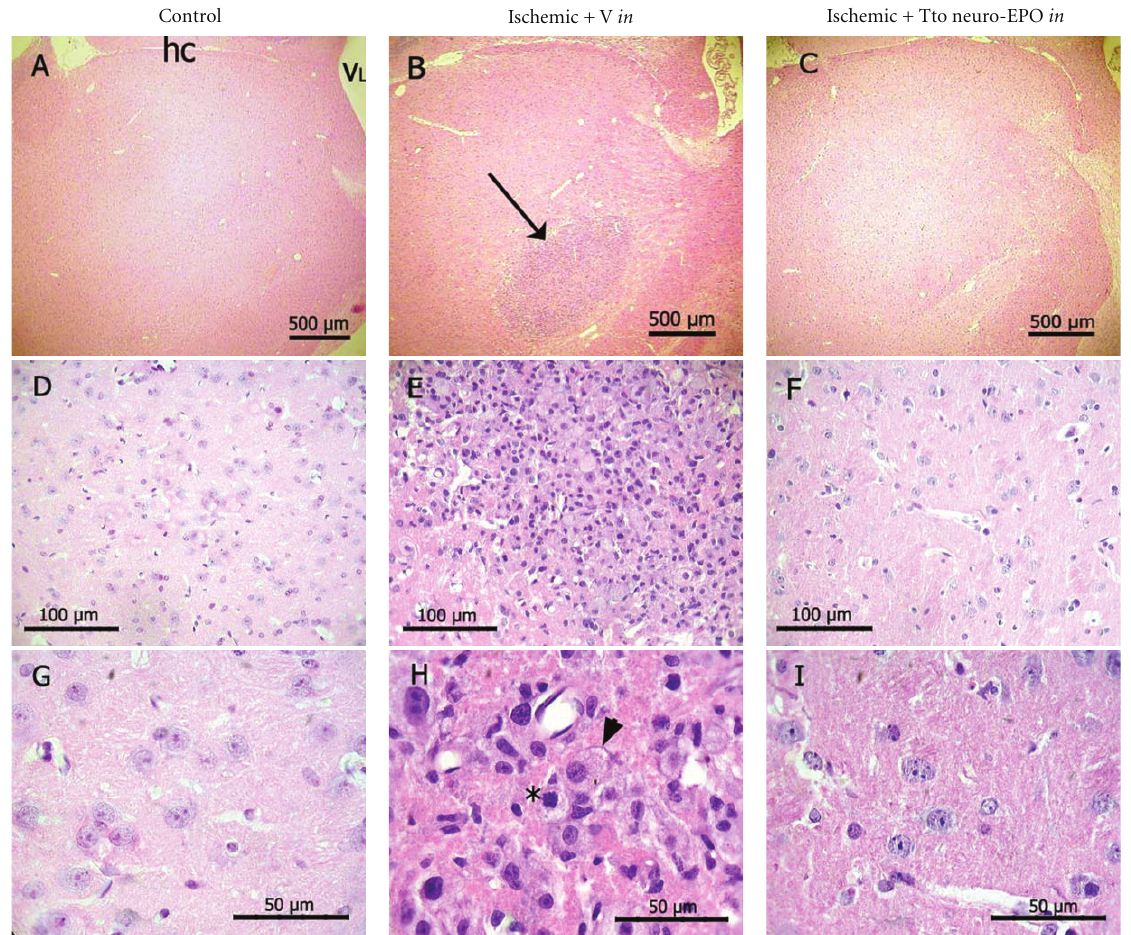
Figure 6: Model of focal ischemia thalamus. Unilateral ischemia produces large clusters of macrophages in the nuclei of the thalamus (B, E, H). The thalamus damage decreases with Neuro-EPO in (C, F, I). H-E. A, B, C: Panoramic view. Arrow: focus of macrophages. VL: lateral ventricle; hc: hippocampus. D, E, F: × 400 thalamus. E: Focus of macrophages. F: Control-like appearance. G, H, I: Thalamus x1000. H: Macrophage with vacuolated cytoplasm (arrowhead), macrophage in mitosis (asterisk). I: Looks like the